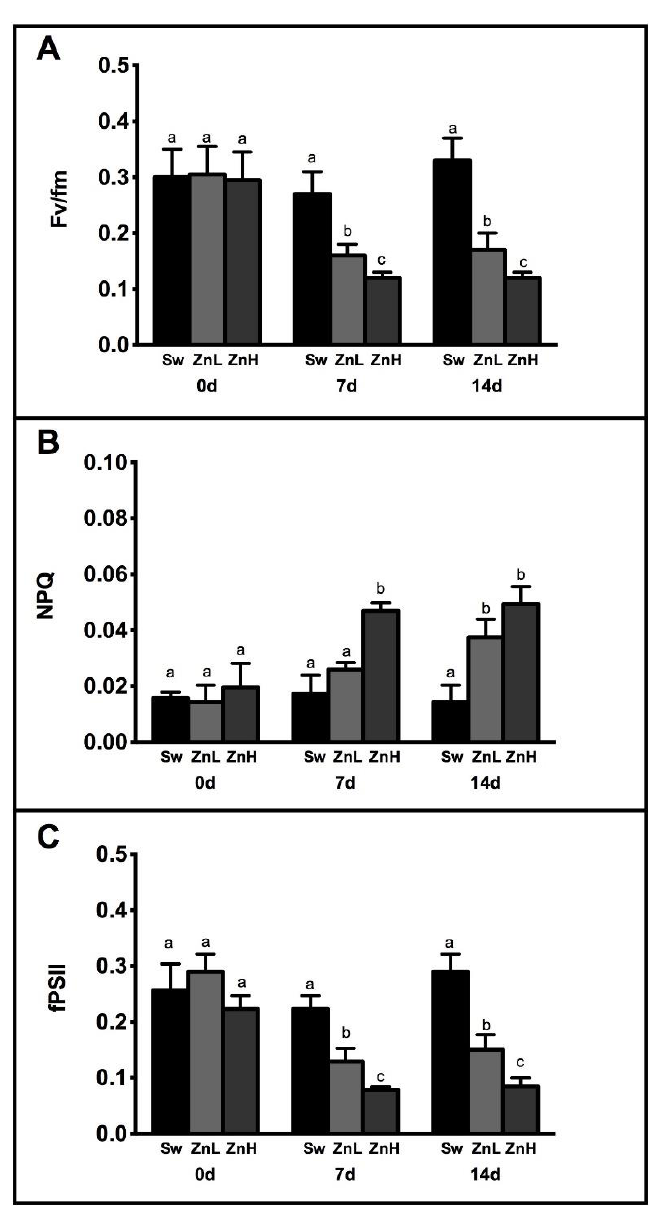
Figure 2. Fv/Fm ( A ), NPQ ( B ) and fPSII ( C ) of Caulerpa grown in seawater (Sw — black bars), sea- water + ZnSO 4 5 mg L −1 (ZnL — light grey bars) and seawater + ZnSO 4 10 mg L −1 (ZnH — dark grey seawater + ZnSO 4 5 mg L − 1 (ZnL—light grey bars) and seawater + ZnSO 4 10 mg L − 1 (ZnH—dark bars) for 14 days. Letters indicate ANOVA significance between treatments. grey bars) for 14 days. Letters indicate ANOVA significance between